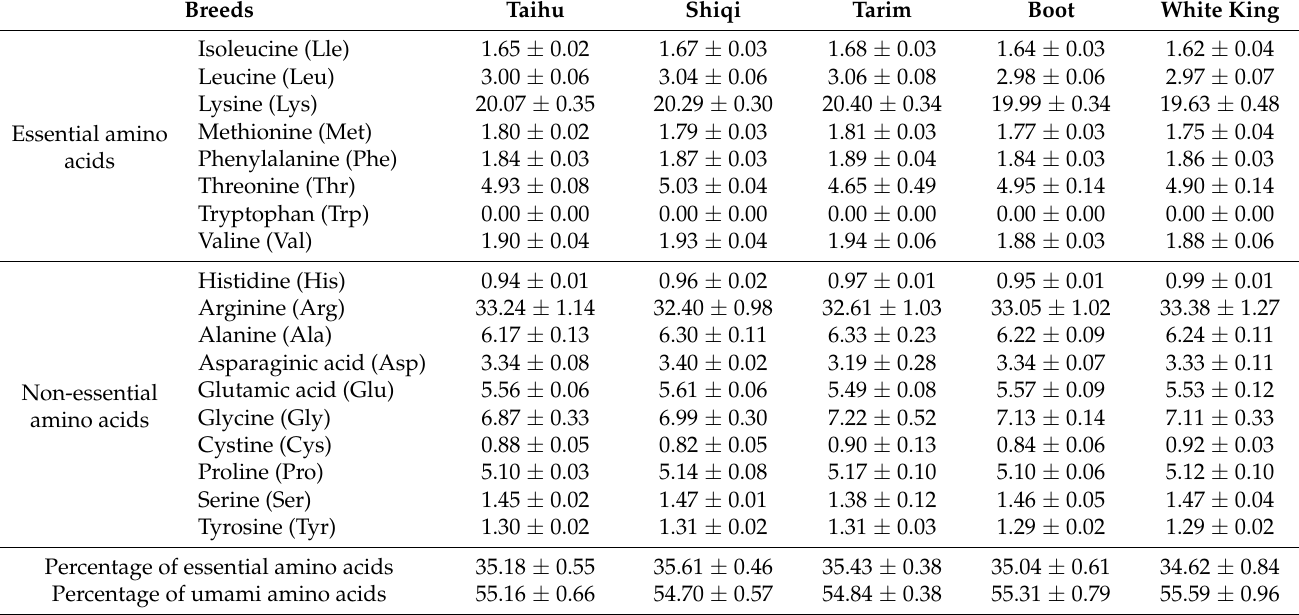
Table 3. Comparison of amino acid contents between different breeds of pigeons